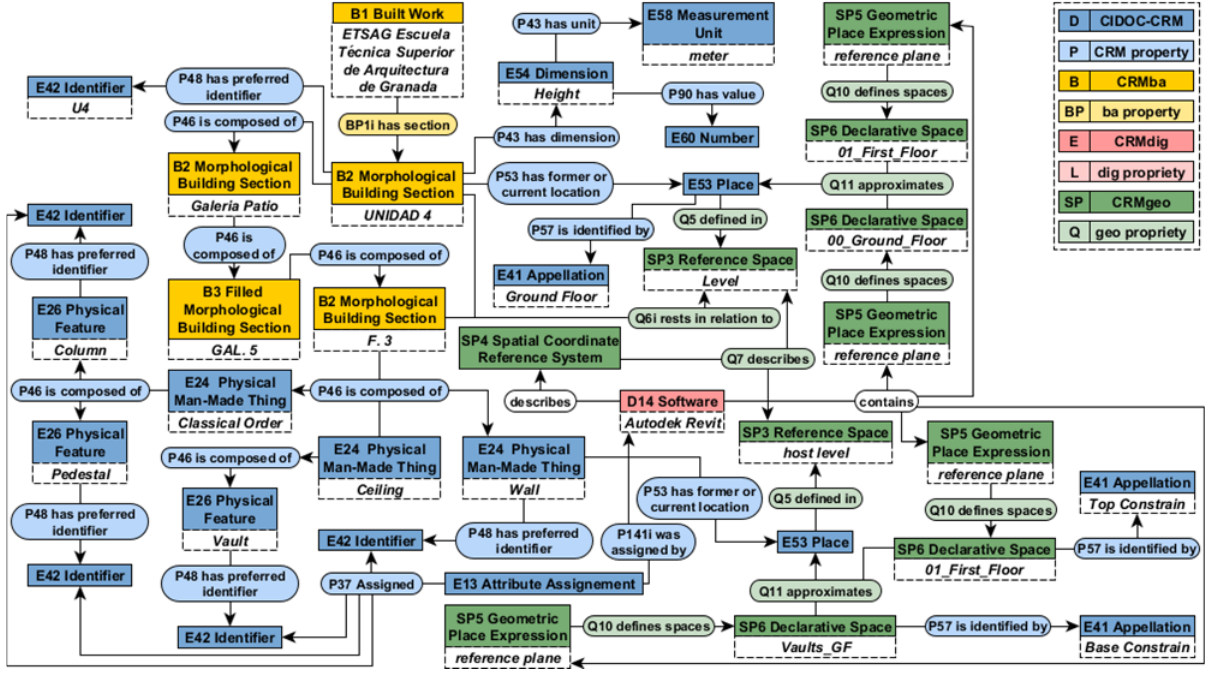
Figure 9. CRMgeo applied to UNIDAD 4 – Ground Floor and level of reference for a level-hosted